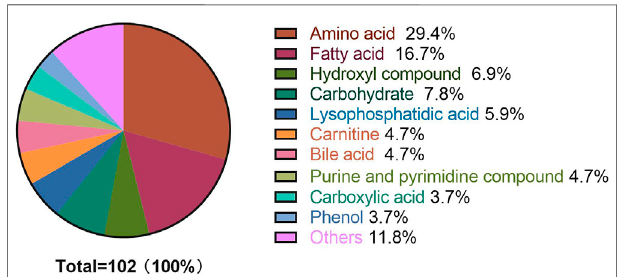
FIGURE 1 | Metabolite classi fi cation analysis. The pie chart shows the 60 metabolites, including amino acids (29.4%), fatty acids (16.7%), hydroxyl compounds (6.9%), carbohydrates (7.8%), lysophosphatidic acids (5.9%), carnitines (4.7%), bile acids (4.7%), purine and pyrimidine